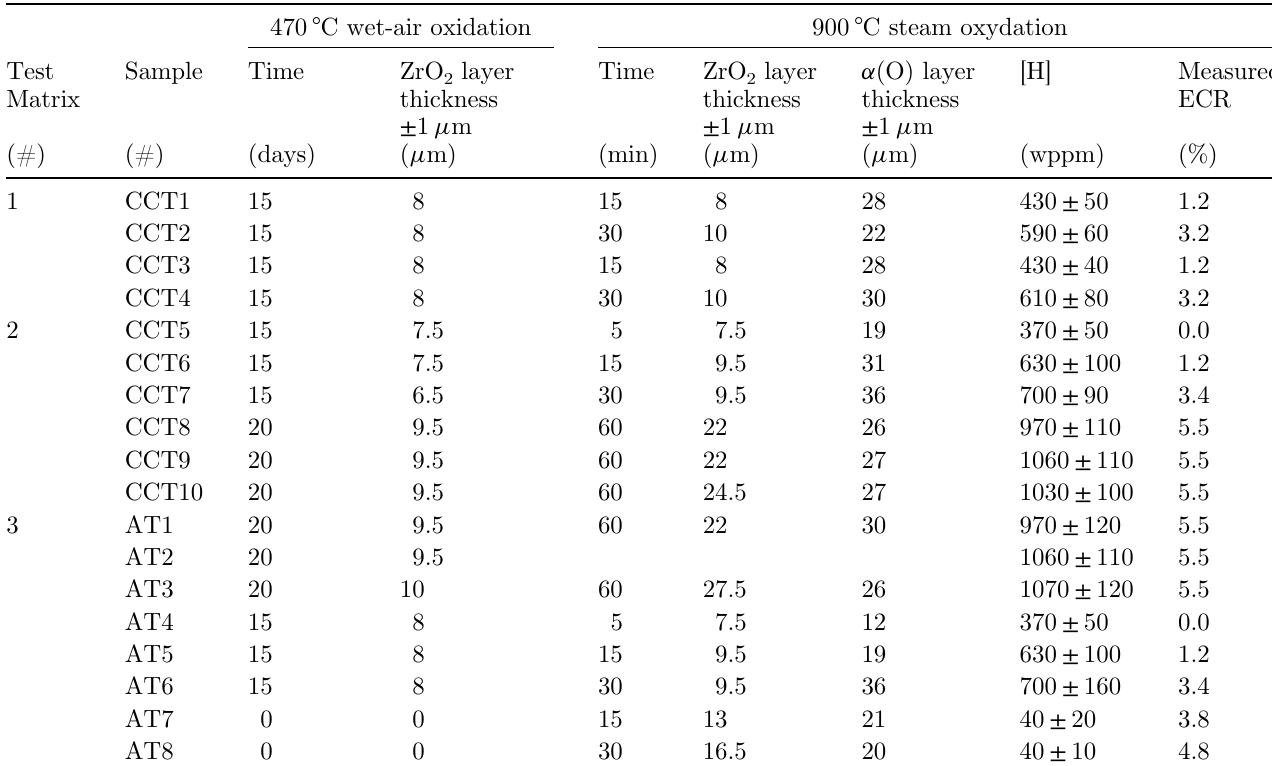
Table 2. Low temperature oxidation conditions and 900 ° C oxidation results for the test